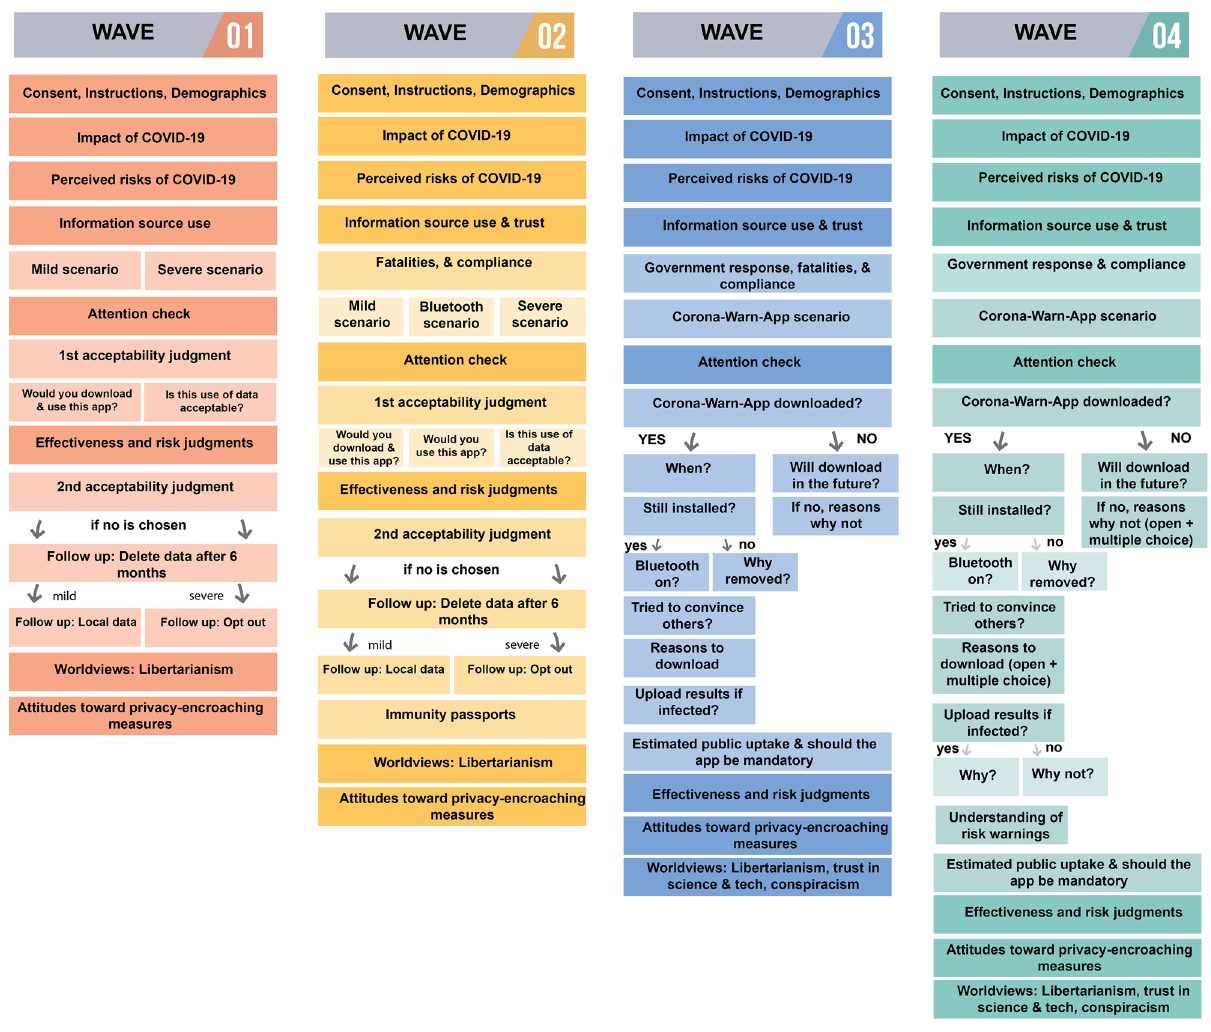
Figure 13. Design of Waves 1–4 of the survey. Each box represents a block of one or more questions. Blocks in deeper shades were common elements across all four waves. For the verbatim text of the scenarios (translated from the German), see Supplementary Table B4. Full questionnaires (in German) are available at https:// osf. io/